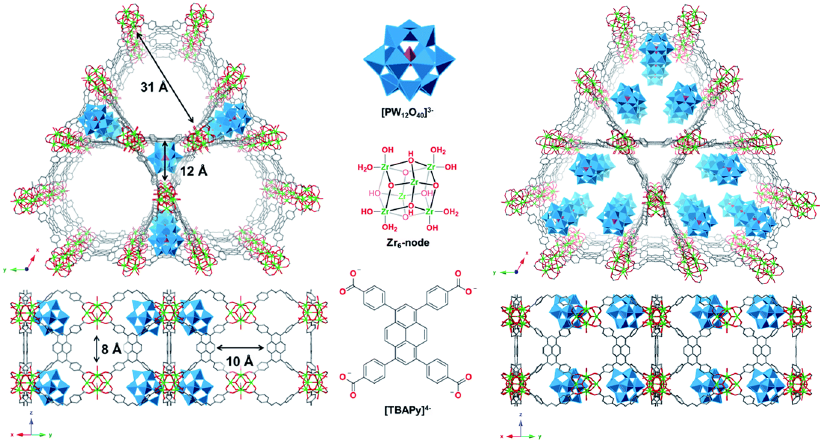
Figure 5. Structural representations of the PW 12 @NU-1000. Reprinted with permission from [86]. Copyright (2018), Royal Society of Chemistry.